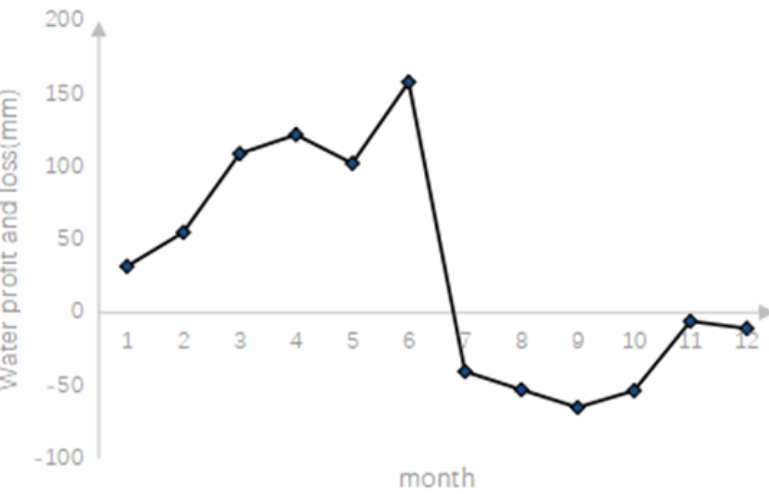
Figure 5. Water surplus and deficit curve of the Poyang Lake region.